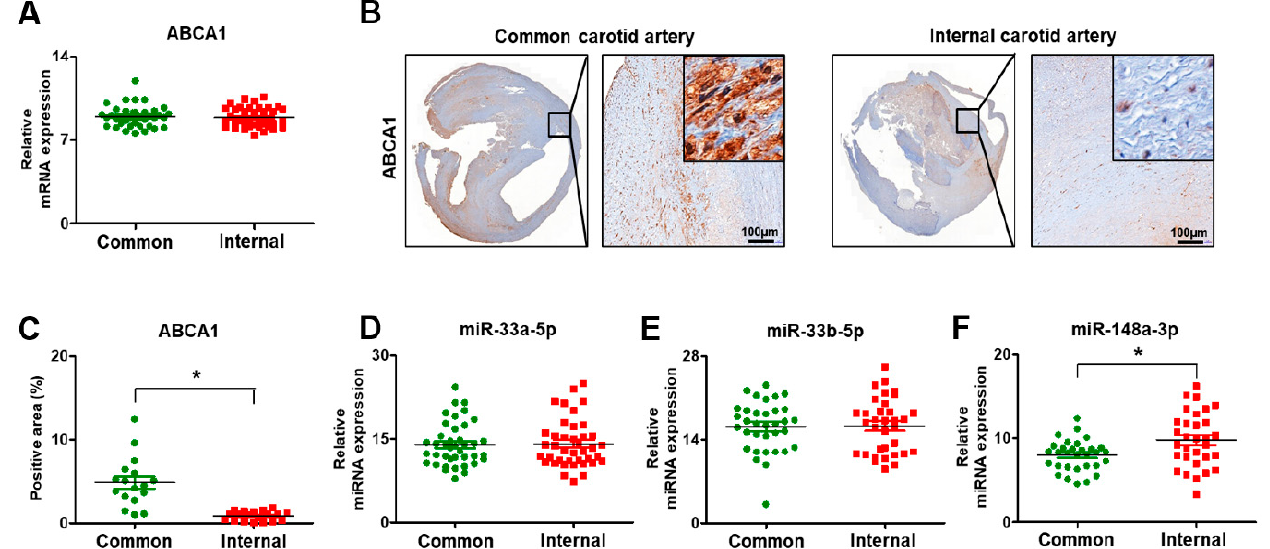
Figure 5. Expression of ABCA1 and its target miRNAs in carotid artery stenosis. ( A ) mRNA expression of ABCA1 by qRT-PCR. ( B ) Expression of ABCA1 by immunohistochemical staining. Scale bar: 100 µ m. ( C ) Quantification of the ABCA1 positive area by immunohistochemistry staining. Expression of miR-33a-5p ( D ), miR-33b-5p ( E ), and miR-148a-3p ( F ) by qRT-PCR. Mean ± SD; * p < 0.05; t -test. Common, common carotid artery; Internal, internal carotid artery.